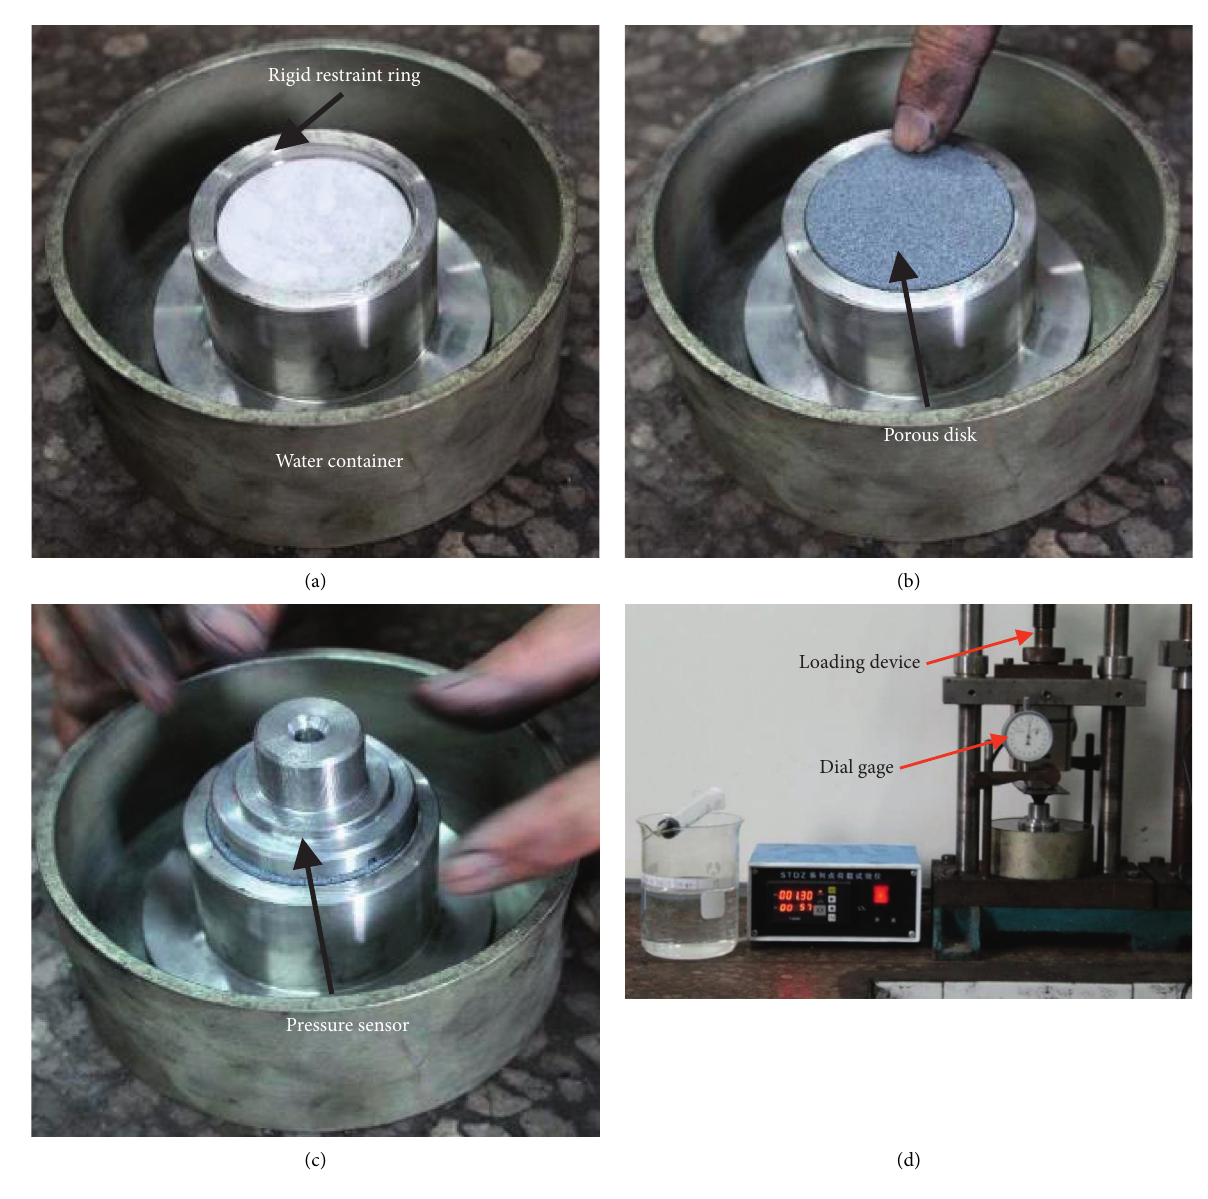
Figure 2: Swelling test